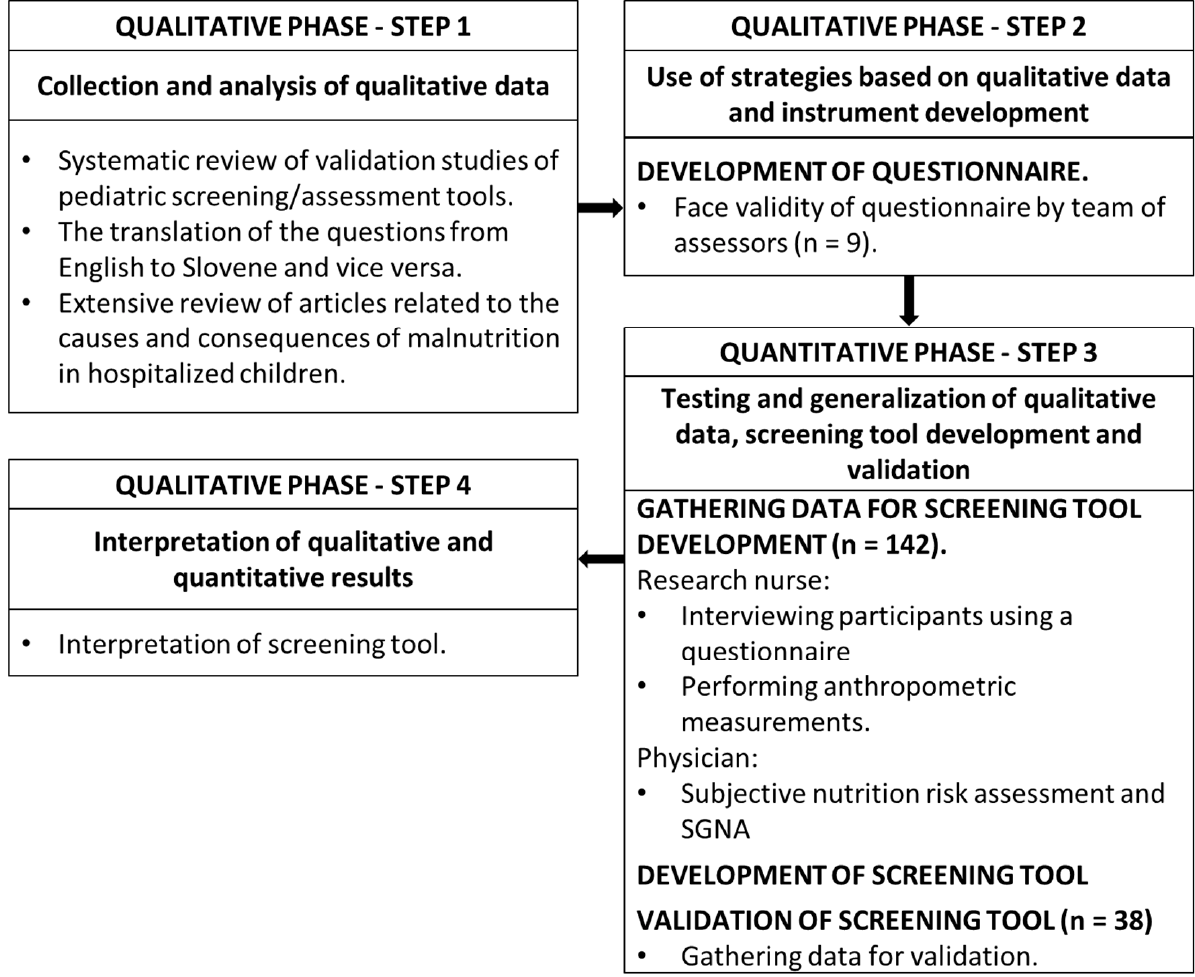
Figure 1. Visual diagram of an exploratory sequential design with the course of the study.